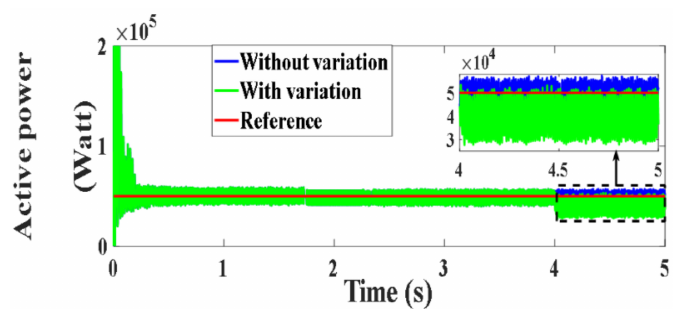
Figure 175. Active power under PVC (Watt).